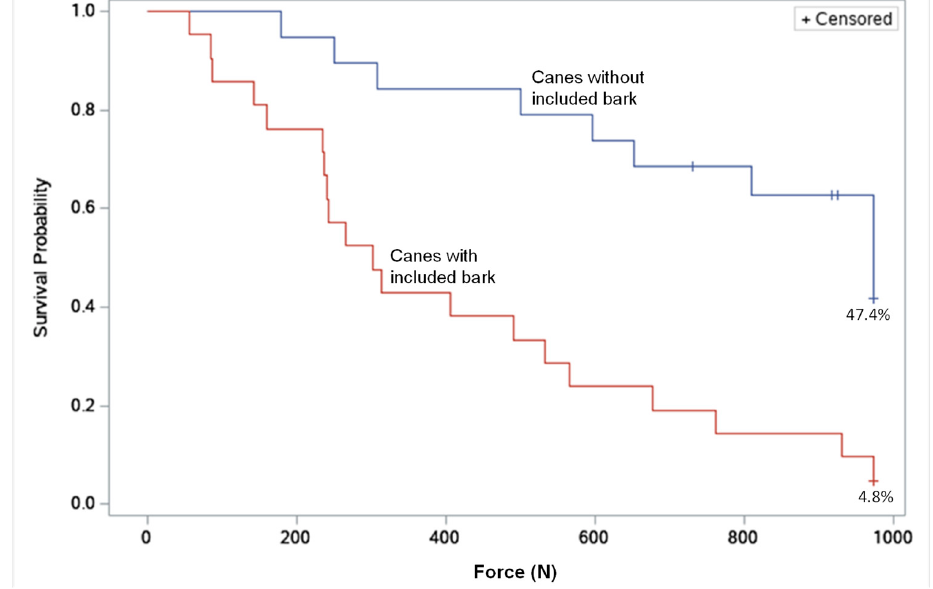
Figure 4. Product limit survival estimates of Farthing southern highbush blueberry cane unions with or without included bark in relation to tension applied to the cane with a winch ( n = 40, study 5). Survival probability in this context refers to the proportion of canes that did not break at a given applied force. Censored data refer to canes that did not break at the maximum applied force of 972.4 N.